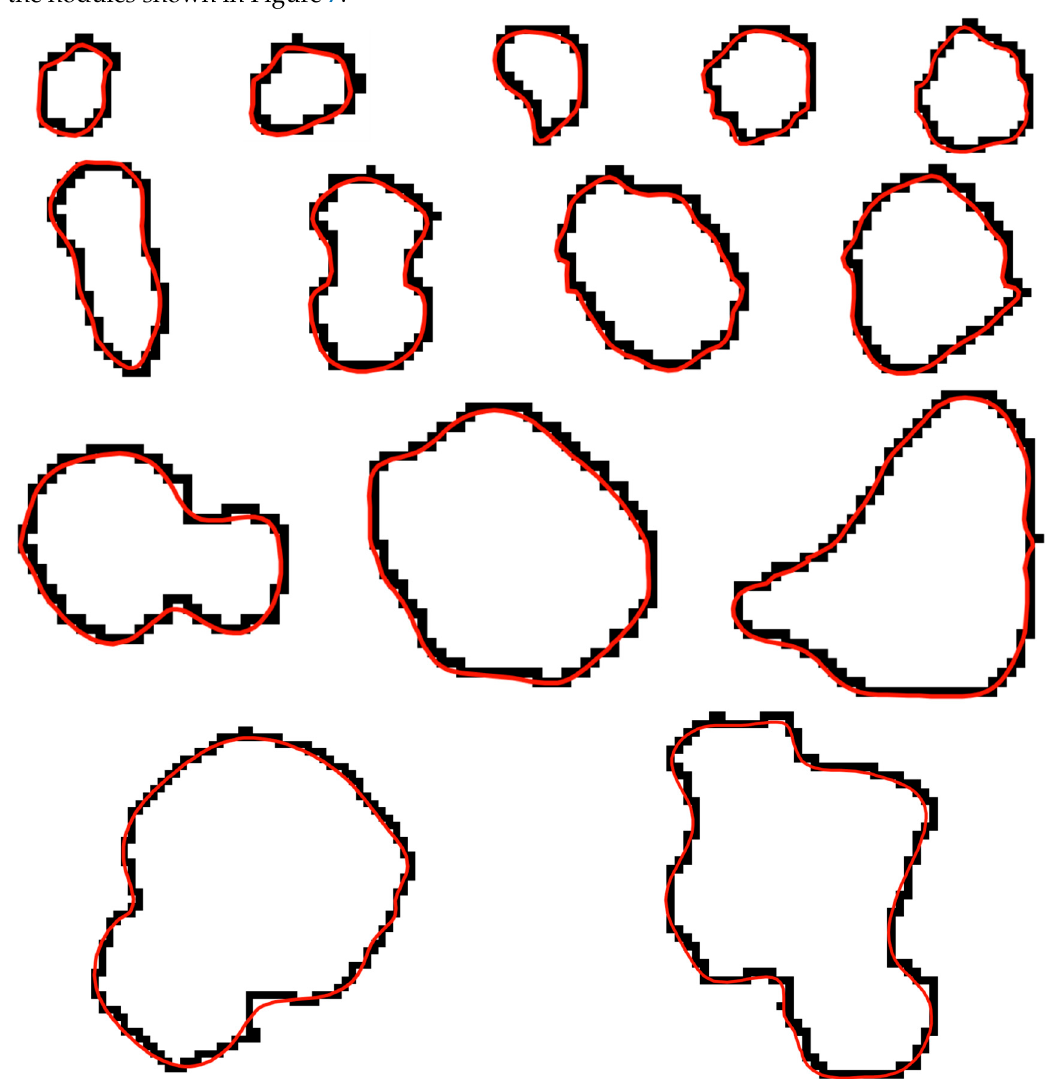
Figure 7. Contours of the 14 graphite nodules: at pixel level obtained by image processing (black) and model curves obtained by genetic algorithms (red).